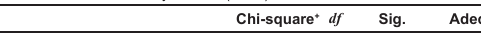
Table 2 Kaiser Meyer Olkin (KMO) and Bartlett’s